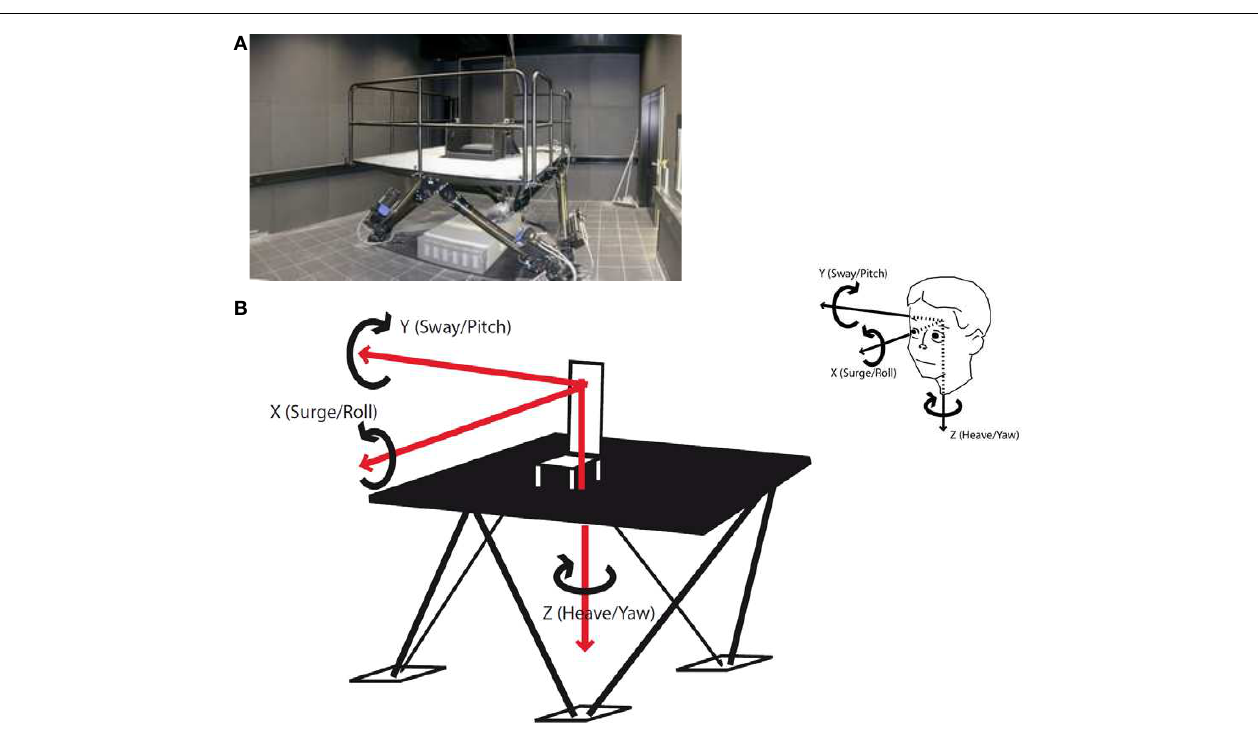
red arrows: back–forth ( x -axis, surge), left–right ( y -axis, sway), and up–down ( z -axis, heave). Additionally, the hexapod allows three rotational movements which are depicted as black loops: sagittal axis ( x -axis, roll), cross axis ( y -axis, pitch), and longitudinal axis ( z -axis, yaw). All possible forms of motion are additionally depicted as projections on a head in the upper right corner of the